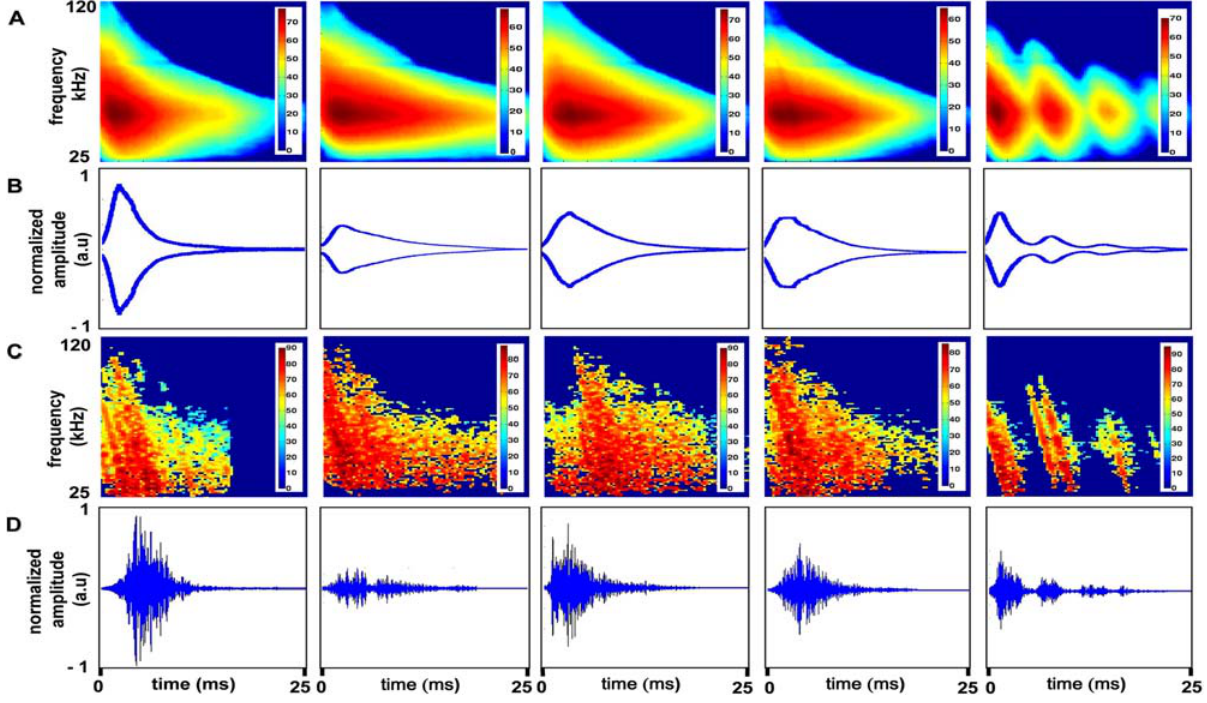
Figure 10. Raw data after preprocessing. In all rows the species from left to right are: apple, spruce, blackthorn, beech, and corn field. In all spectrograms, color bars are in dB. The units in the time signals are arbitrary. (A) The average spectrogram of each plant species. (B) The average envelope of the time signal of each plant species. (C) The corresponding example of a single spectrogram of each plant species (the effect of applying the threshold is noticeable). (D) The corresponding example of a single echo of each tree in the time domain.